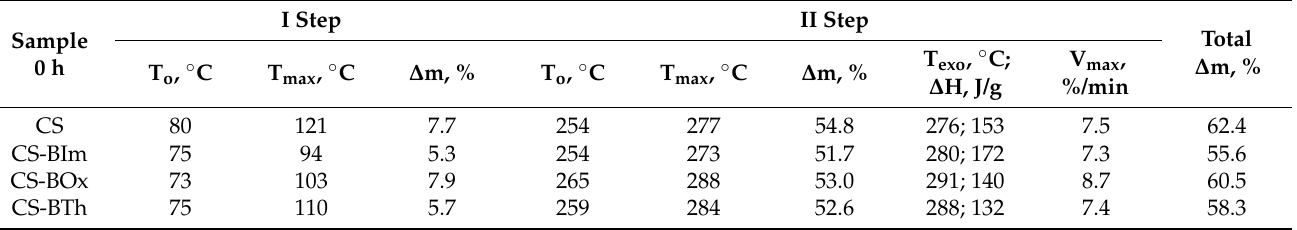
Table 2. Thermal parameters of unirradiated (0 h) chitosan and modified chitosan samples determined from TGA/DSC